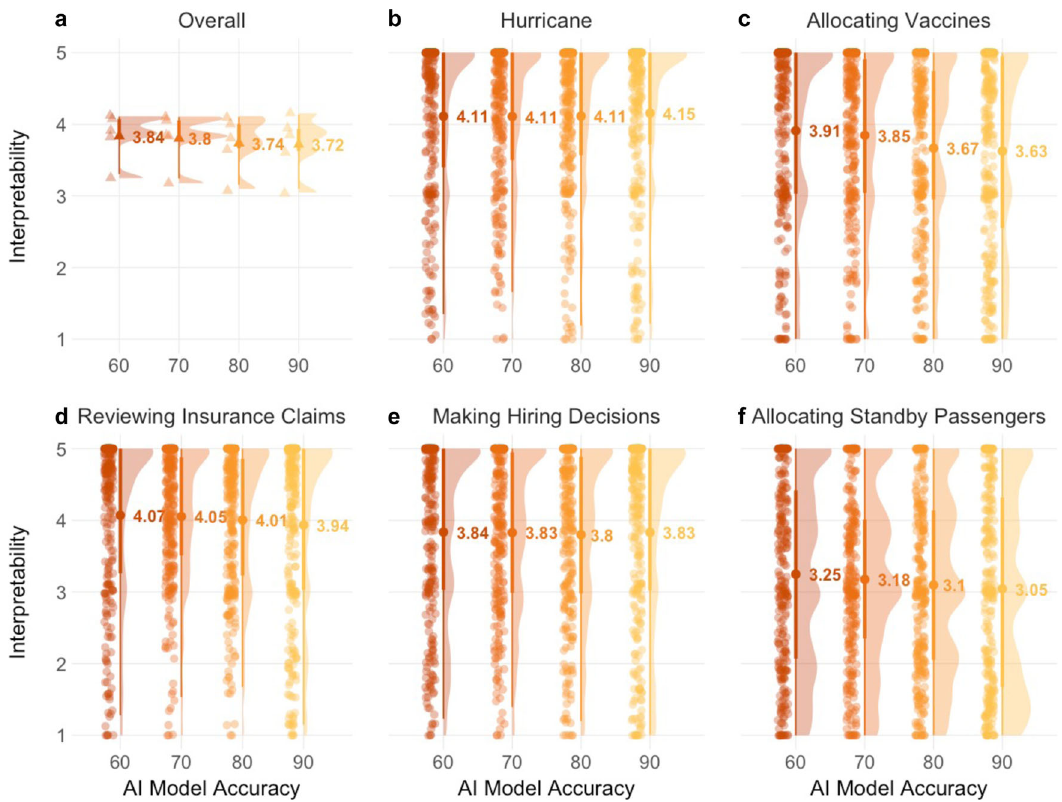
Fig.4|ResultsforStudy3A. Participants ’ responsesfromStudy3A( N =261)tothe question “ How important is it that the given AI model is explainable? ” on con- tinuousslider-scalesfrom “ notatallimportant ” (1)to “ extremelyimportant ” (5).For each AI model with a given level of accuracy, there was a separate slider-scale. Panelsshowthejitteredrawdata,itsdensity,thepointestimateofthemeanwithits 95% con fi dence intervals, and interquartile ranges. Overall, there was a slight